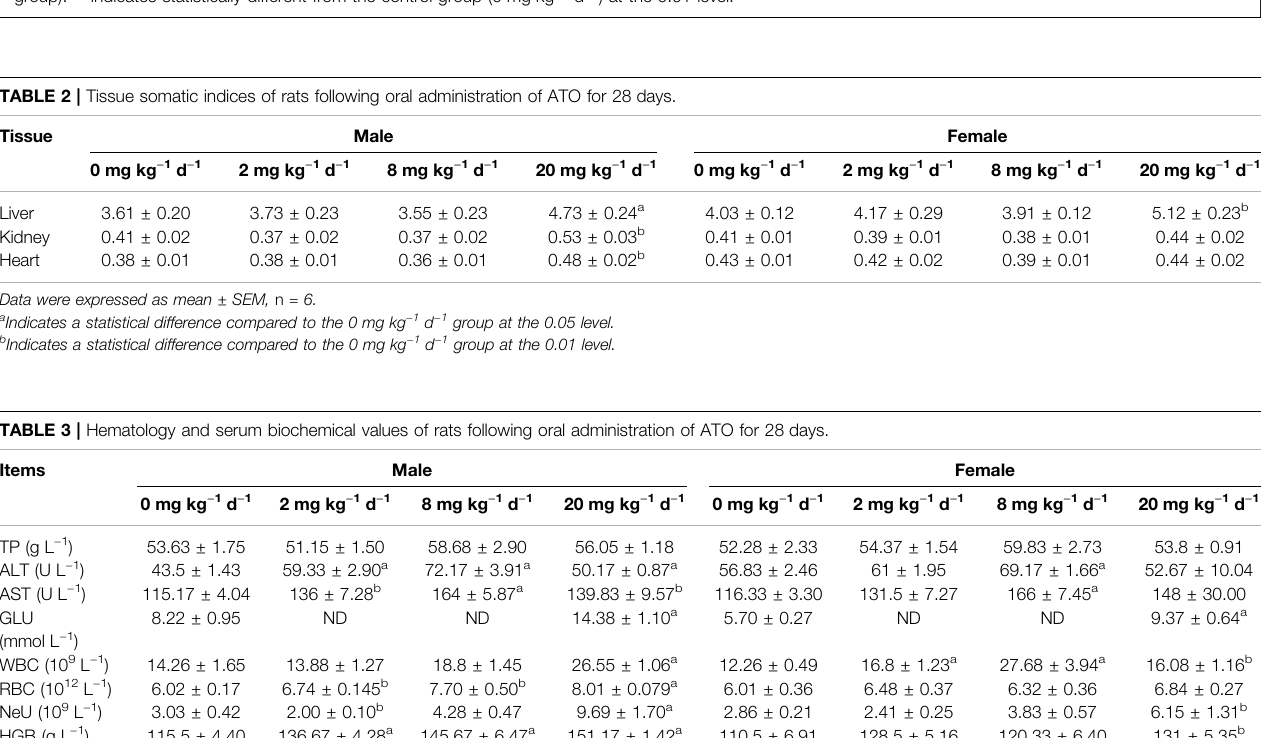
FIGURE3| Meanbodyweightofmalerats (A) andfemalerats (B) followingintragastricadministrationofATOfor28 days,respectively(mean ± SEM, n (cid:2) 6foreach group). ** indicates statistically different from the control group (0 mg kg − 1 d − 1 ) at the 0.01 level.